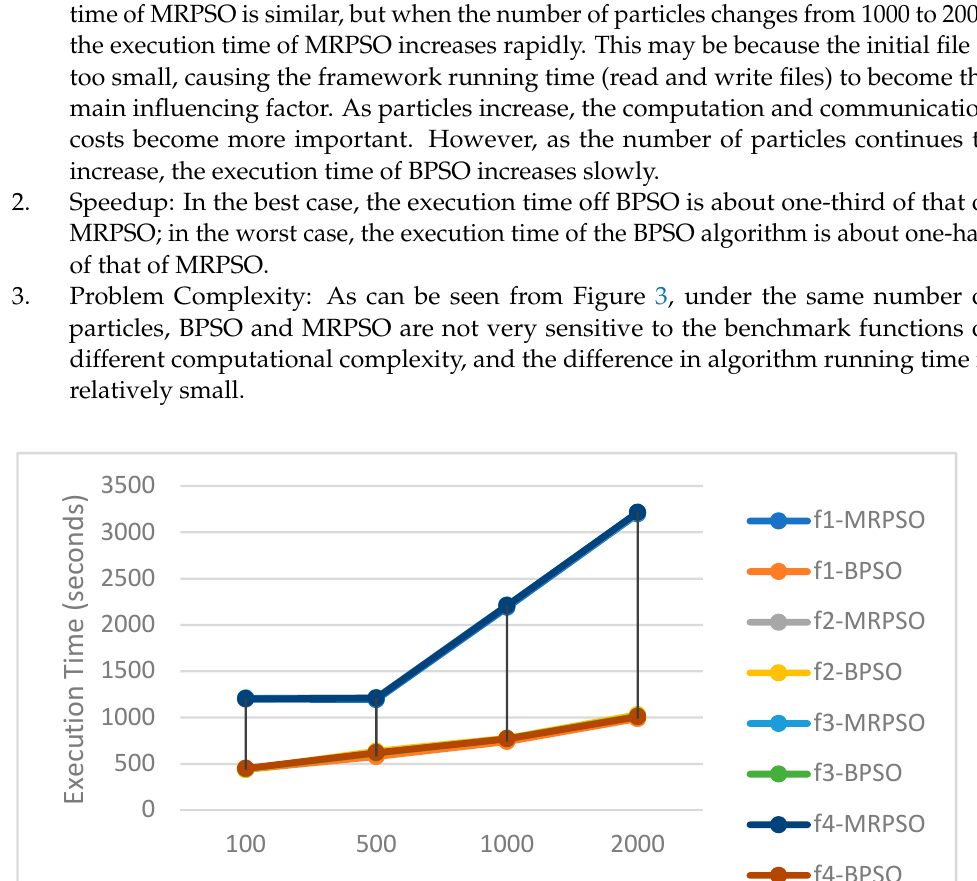
8 of 13 Table 4. MRPSO and BPSO running time and speedup on 𝑓 (cid:2871) . N 3.17 Table 5. MRPSO and BPSO running time and speedup on 𝑓 (cid:2872) . N